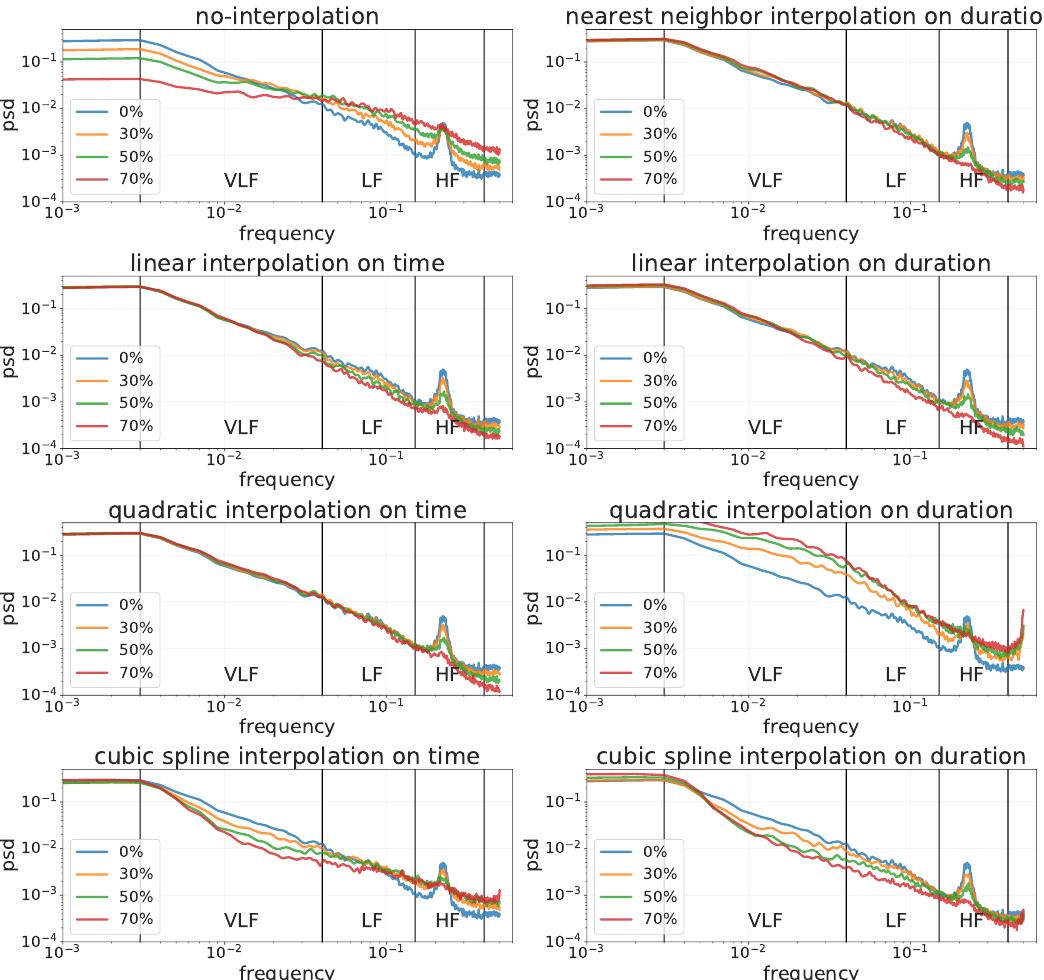
Figure 5. Frequency analysis of a user’s RR-intervals timeseries recorded in 5 min with different percentages of missing values (i.e., 0%, 30%, 50% and 70%) handled with different interpolation methods (i.e., nearest neighbor, linear, quadratic and cubic spline) on both time and